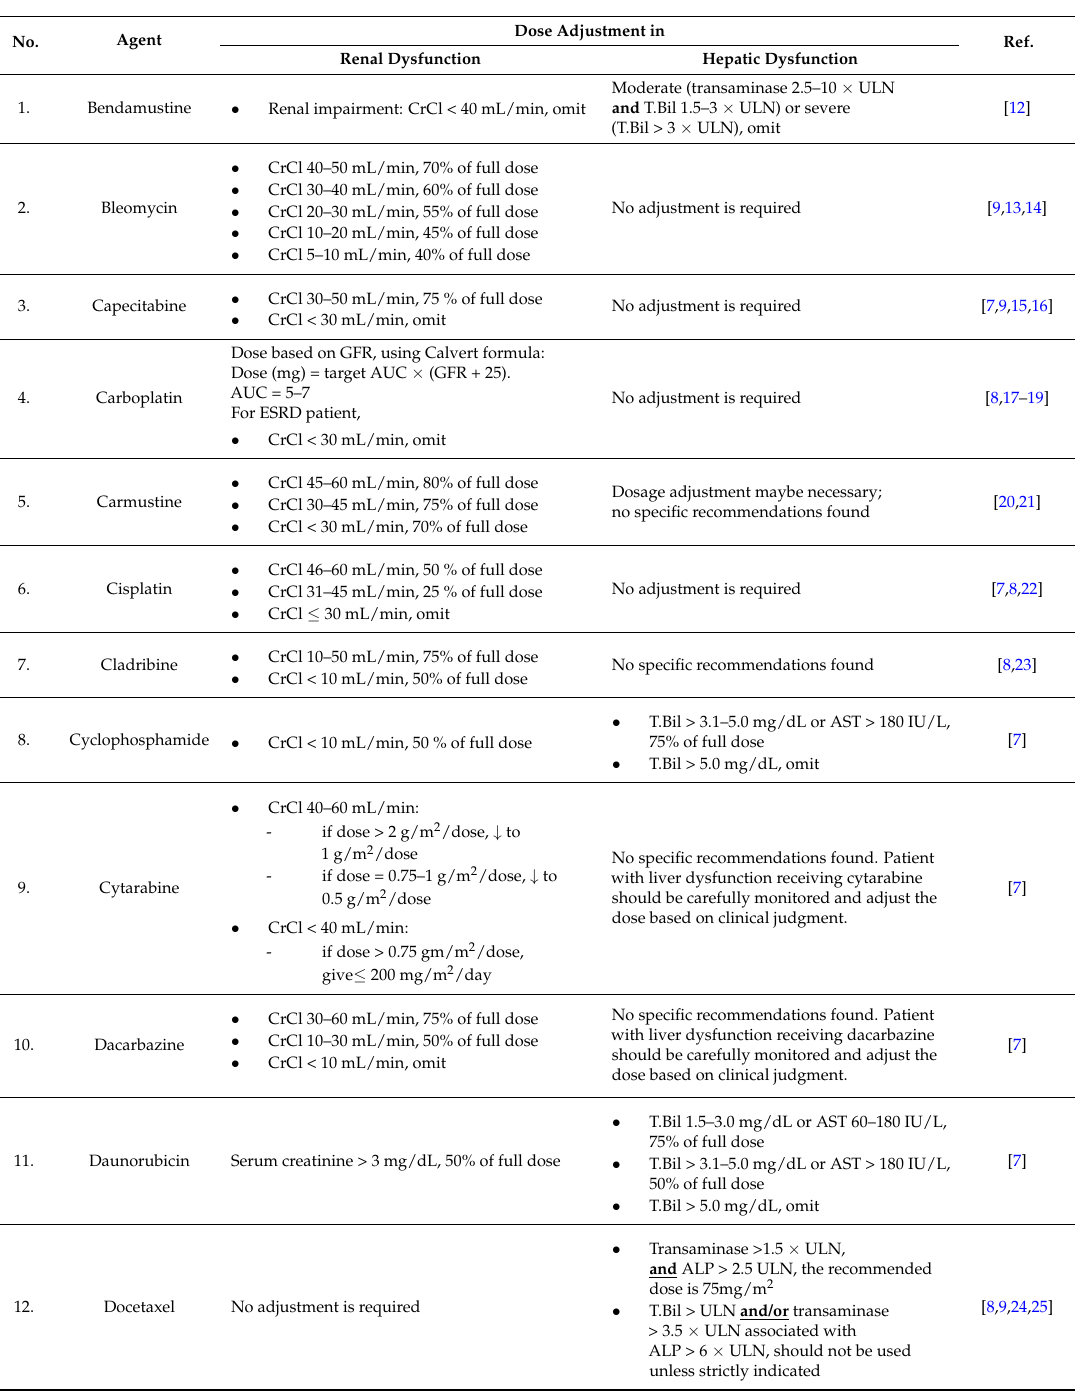
Table 1. Dosing guidelines of selected anticancer agents for patients with renal and/or hepatic